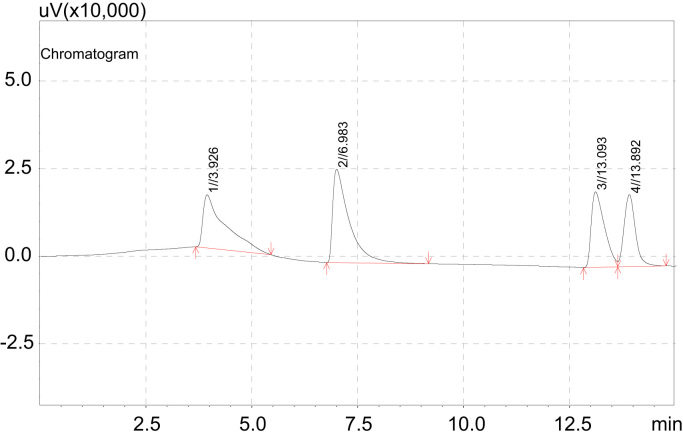
Sample standard.